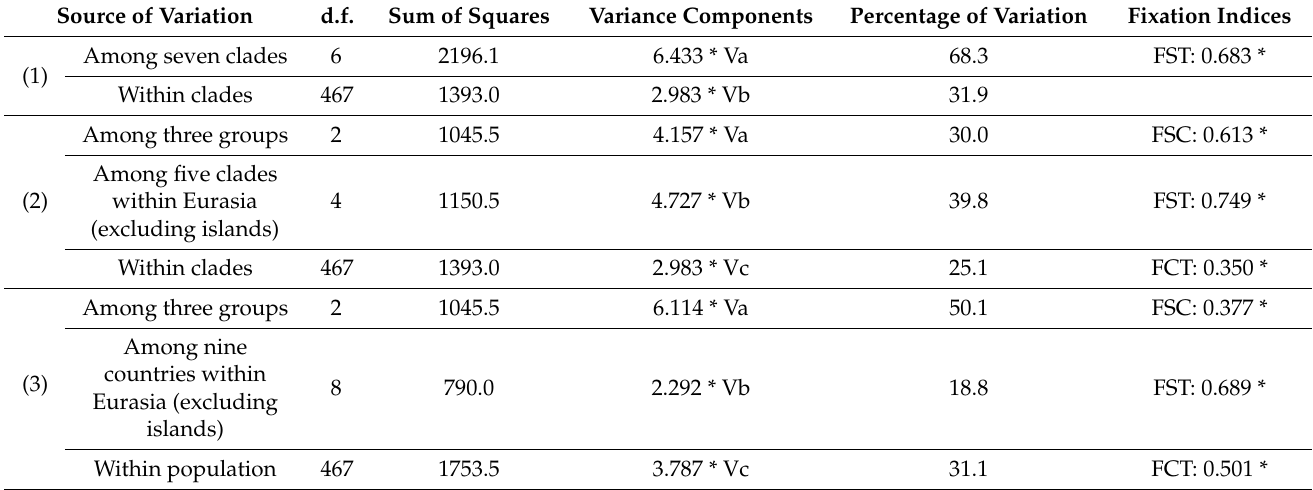
Table 2. Analysis of molecular variance (AMOVA) for A. agrarius using mtDNA between (1) seven clades C1–C7, (2) three groups (Eurasia, Taiwan and Jeju Island) from these clades, and (3) three groups (Eurasia, Taiwan and Jeju Island) stratified according to countries/populations. *—statistically significant values ( p <